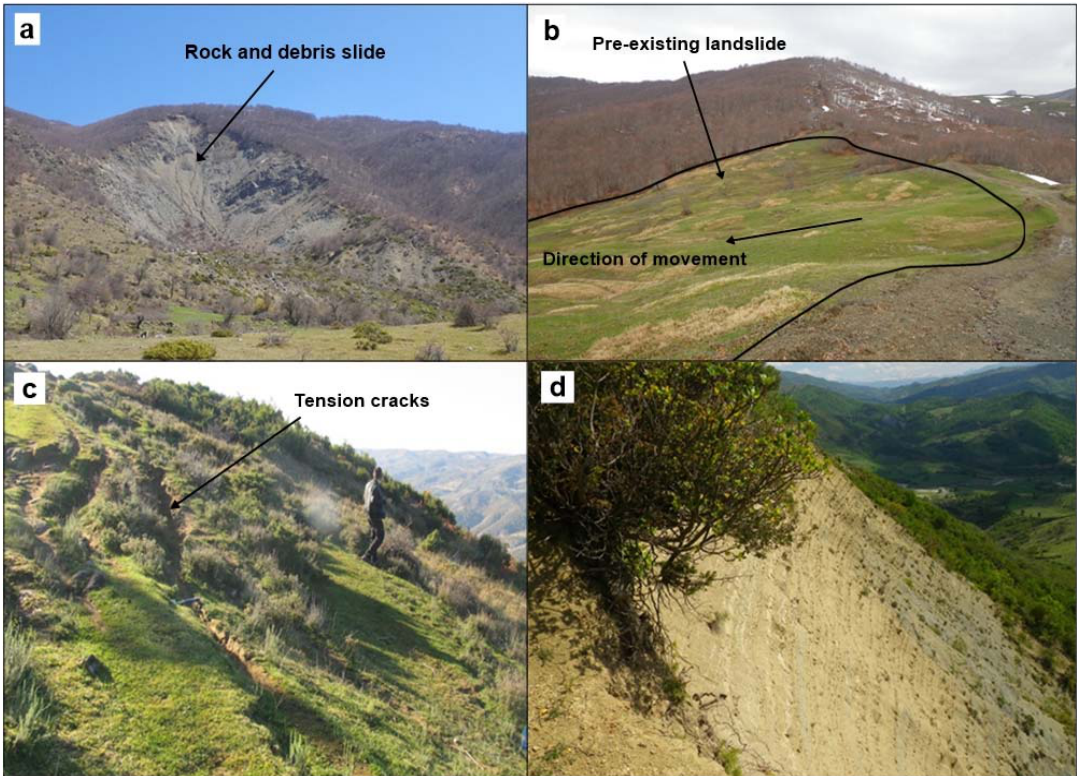
Figure 14. a : New failure (rock and debris slide) in the Potom valley (avoided by the re ‐ route), b : Pre ‐ existing landslide on the flank of a ridge, where a pipeline route runs, c : Tension cracks along a ridge flank, indicating potential for upslope retrogression of pre ‐ existing landslides, d : Very steep landslide back scar extending to the ridge crest, with potential for further upslope retrogression.